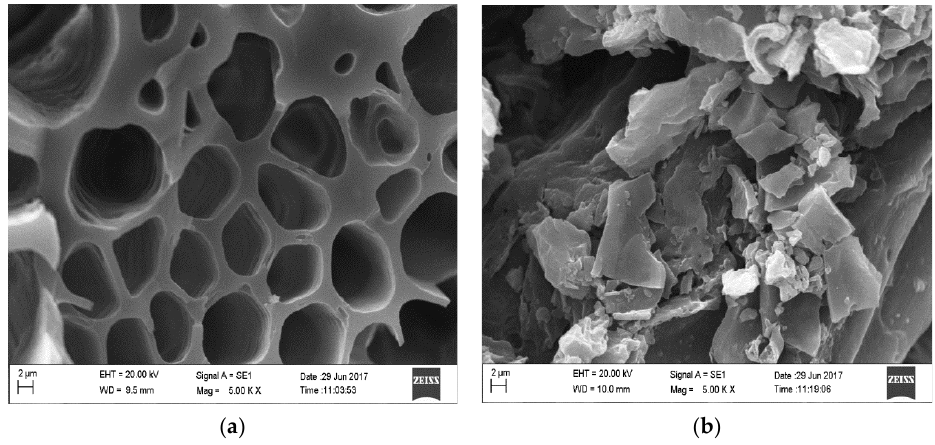
Figure 1. SEM morphology of Sterculia alata fruit shell biochar for the adsorption of Patent Blue V dye; ( a ) before adsorption; ( b ) after adsorption. Table 1. Elemental composition by EDX analysis of biochar and biomass